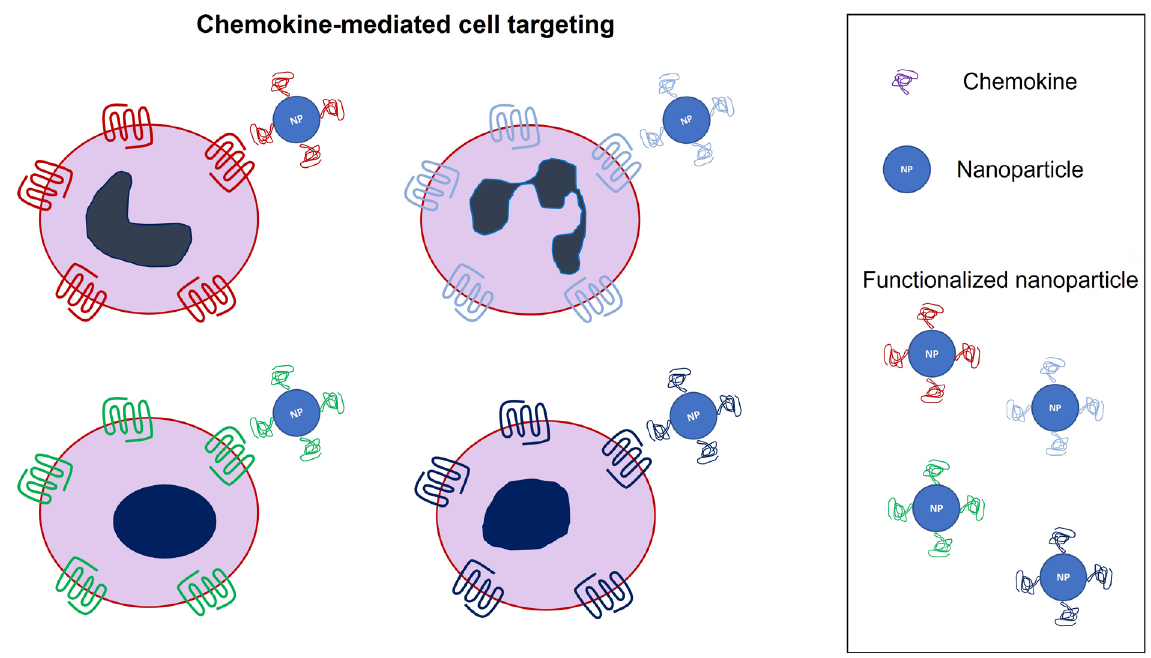
Figure 1. Schematic representation of cellular targeting exploiting selective chemokine-receptor binding